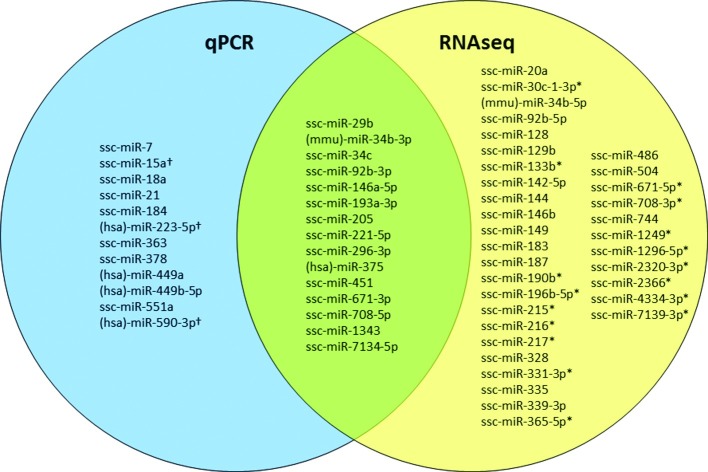
Venn diagram comparing differentially expressed miRNAs identified by and qPCR and RNAseq.Overlap of miRNAs found to be differentially expressed at one or more post-challenge time points by RNAseq (yellow) and qPCR (blue). †miRNAs assayed by qPCR but not detected by sequencing; *miRNAs detected by sequencing, but not assayed by qPCR. When a known porcine (ssc) sequence for a given miRNA was not available in miRBase (v. 21), human (hsa) or mouse (mmu) names are applied in accordance with the homolog that best matched the novel porcine miRNA discovered in the RNAseq data, and these homolog sequences were likewise used for qPCR primer design.